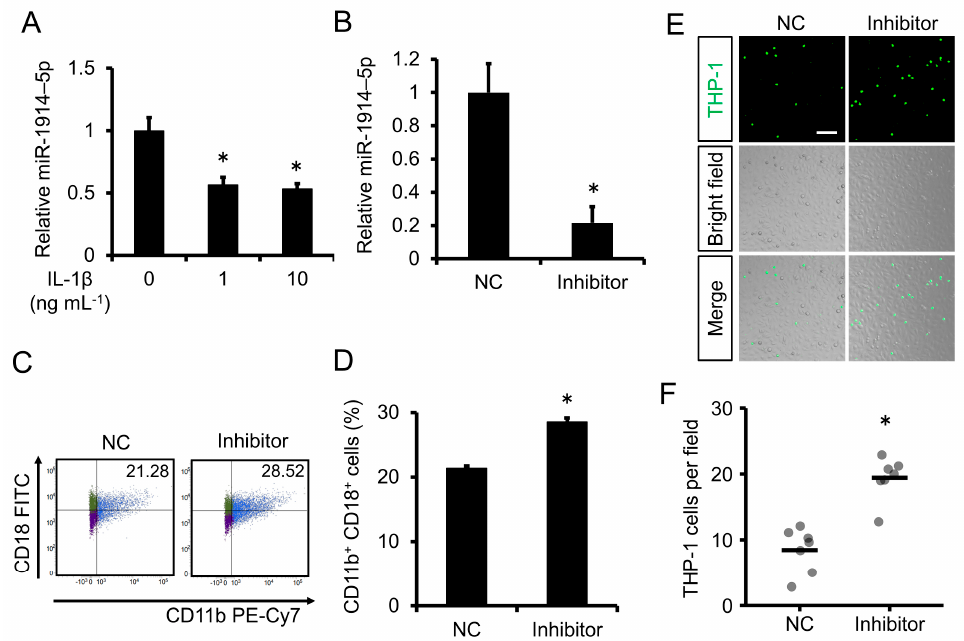
Figure 2. IL-1 β decreased miR-1914-5p expression in monocytes, and transfection with a miR-1914-5p inhibitor increased monocyte adhesion to endothelial cells. ( A ) THP-1 cells were incubated with IL-1 β for 24 h, and miR-1914-5p expression was examined by qRT-PCR. n = 3 in each group. * p < 0.05 compared with the vehicle group. ( B ) THP-1 cells were transfected with miR-1914-5p inhibitor or negative control (NC) inhibitor for 24 h. miR-1914-5p levels were then assessed by qRT-PCR. An inhibitor of miR-1914-5p significantly suppressed miR-1914-5p accumulation in THP-1 cells compared with the NC. n = 3 per group. * p < 0.05 compared with the NC transfected group. ( C ) Mac-1 expression in THP-1 cells was examined by flow cytometry after transfection with miR-1914-5p in- hibitor or NC for 24 h. THP-1 cells expressing Mac-1 were defined as CD11b + , CD18 + cells. ( D ) Pro- portion of cells expressing Mac-1 (CD11b + , CD18 + cells) among live cells. n = 3 in each group. * p < 0.05 compared with the NC transfected group. ( E ) Adhesion of THP-1 cells to an EA.hy926 cell mon- olayer. Fluorescent THP-1 cells and EA.hy926 cells were co-cultured for 1 h after transfection with miR-1914-5p inhibitor or NC for 24 h. Scale bar represents 100 μ m. ( F ) The number of fluorescent THP-1 monocytes on the EA.hy926 cell monolayer was determined. n = 7 fields in each group. * p < 0.05 compared with the NC transfected group. 2.4. Inhibition of miR-1914-5p Expression in Human Monocytes Upregulated the Expression of MCP-1 and Increased Monocyte Transmigration through a Human Endothelial Cell Layer Next, we assessed whether inhibition of miR-1914-5p expression in THP-1 cells af- fects their transmigration through an endothelial cell layer. THP-1 cells in which miR- 1914-5p expression was suppressed exhibited increased accumulation of transcripts of the MCP-1 gene even in the absence of IL-1 β (Figure 3A). Compared with the negative control, the fluorescence intensity associated with THP-1 cells expressing low levels of miR-1914- 5p was increased in the lower transwell chamber, indicating enhanced transmigration of these cells (Figure 3B). Moreover, the number of THP-1 cells on the underside of the mem- brane was increased (Figure 3C,D).